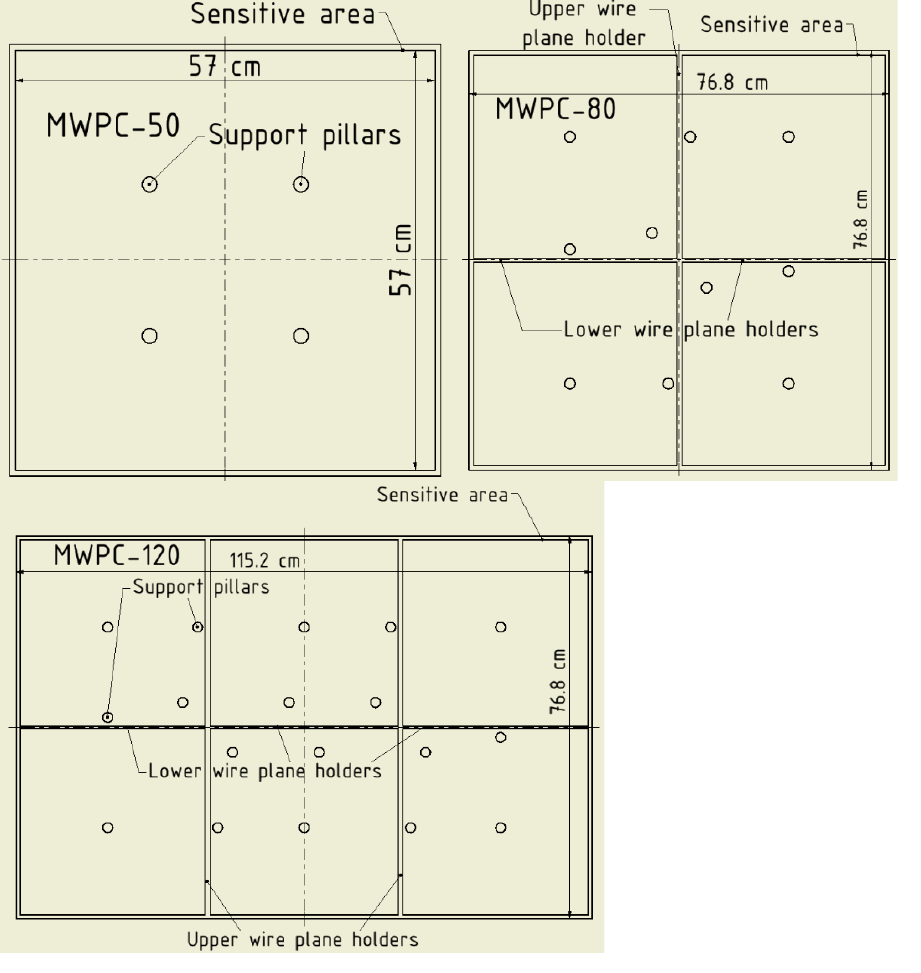
Figure 1. The schematic view of three standard MWPC chamber types. The inner support structure (Support pillars and wire plane holders) becomes more and more complex as the sensitive area increases, in order to guarantee mechanical stability for field